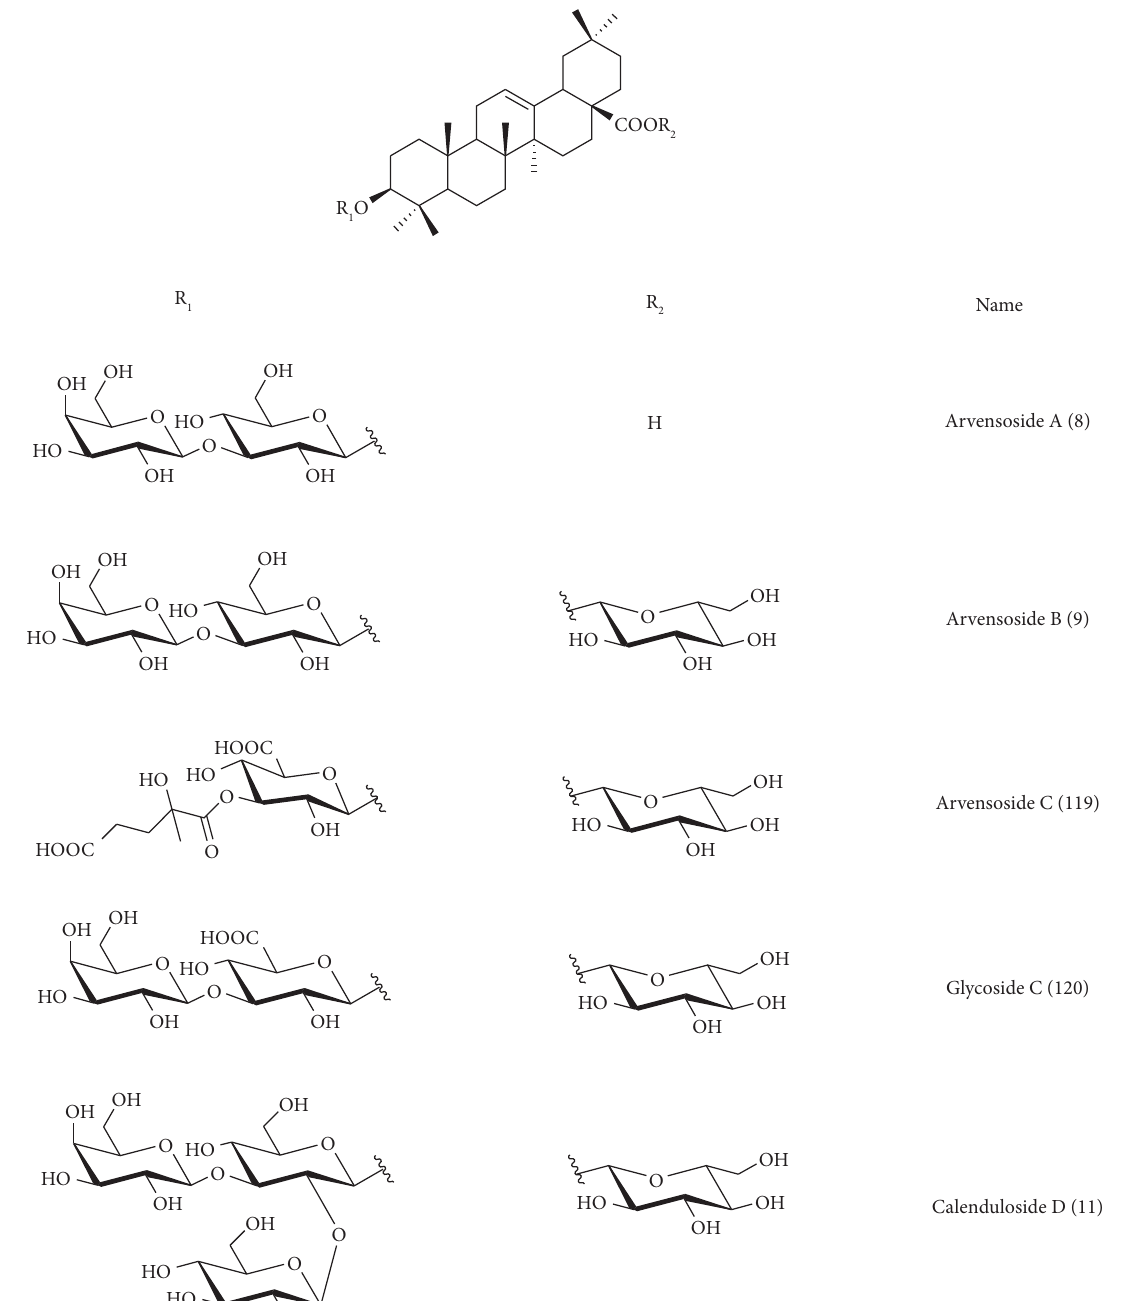
Figure 6: Structure of saponin compounds detected in C.